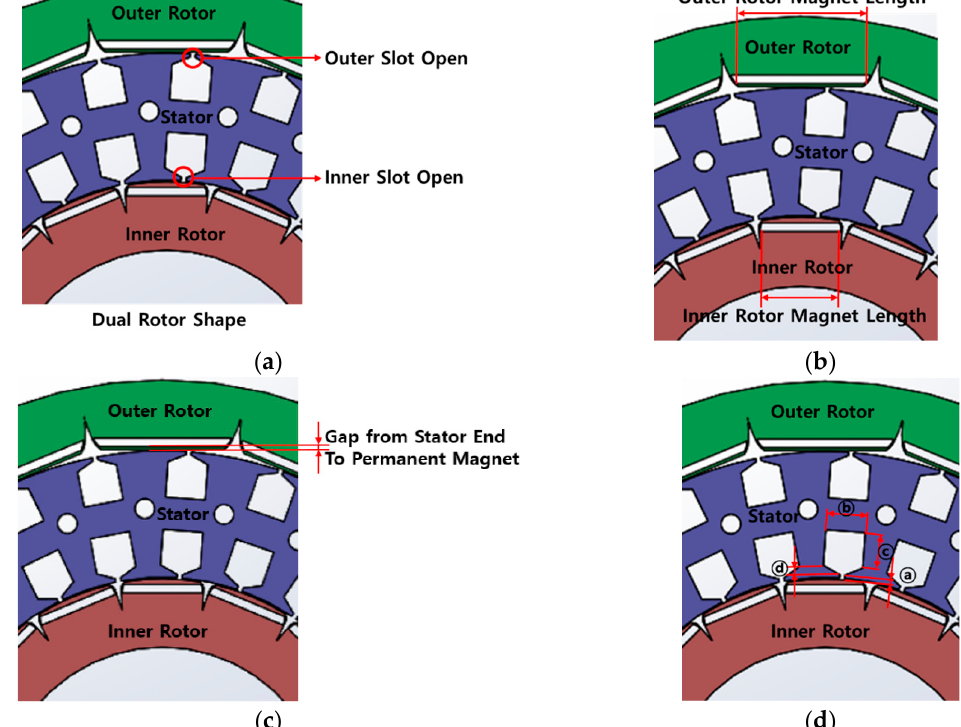
Figure 3. Cogging torque analysis experiments. ( a ) Analysis based on slot opening of the stator; ( b ) Analysis based on magnet length; ( c ) Analysis based on distance between magnet and stator tip; ( d ) Analysis based on stator shape.